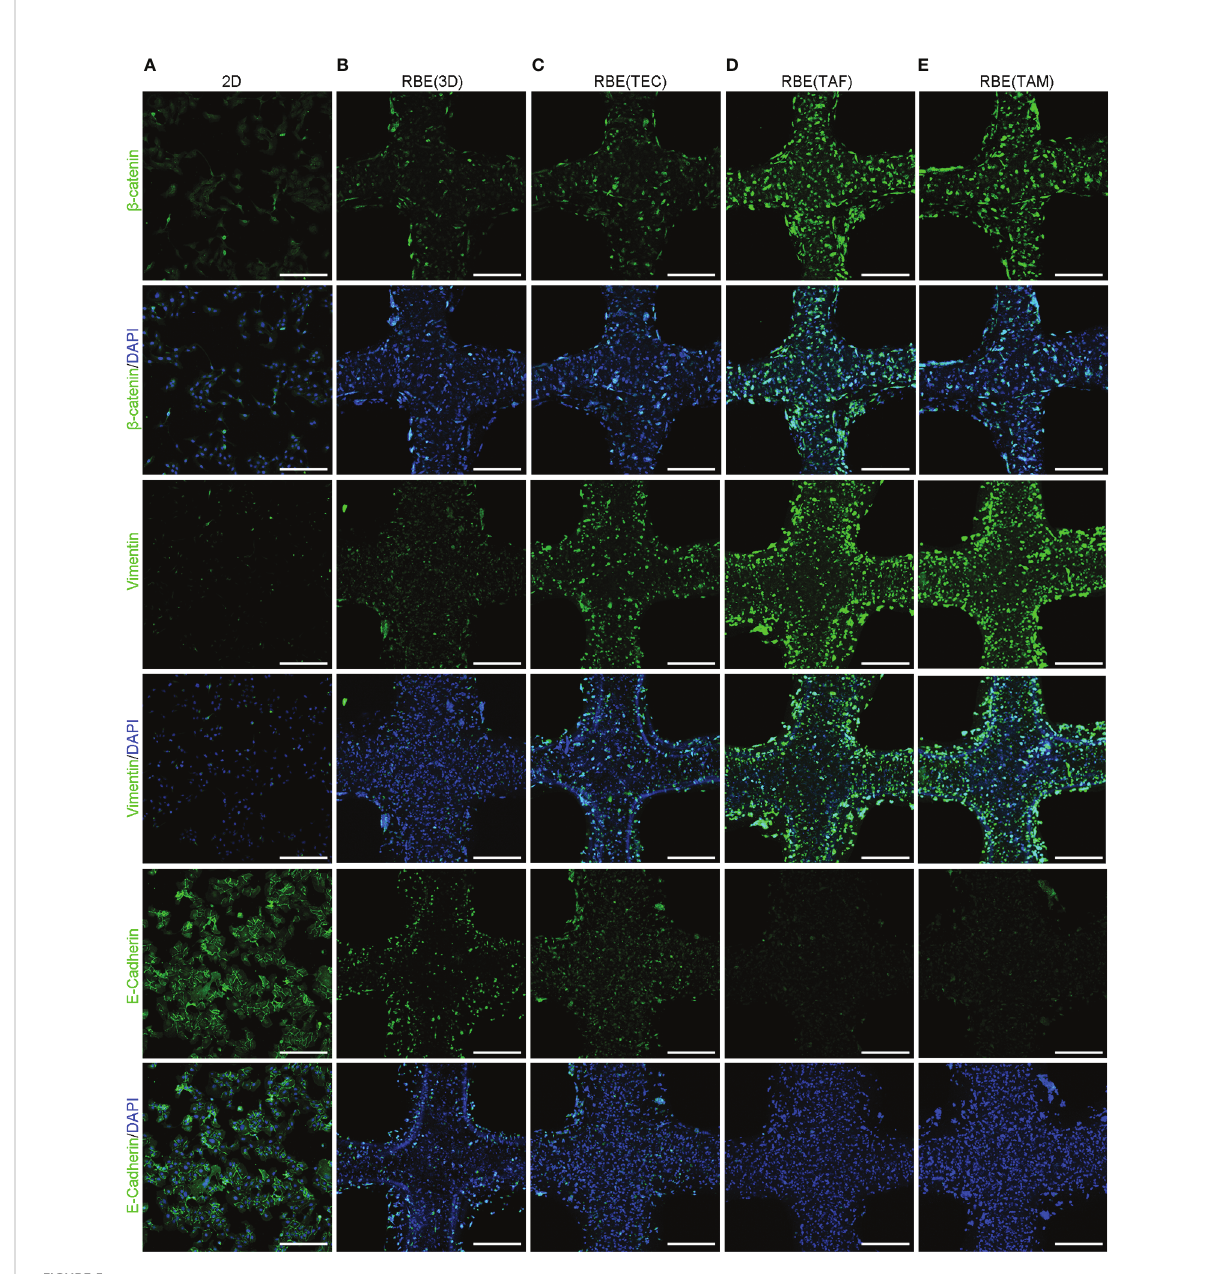
FIGURE 5 3D bioprinting promotes EMT may via the Wnt/ b -catenin pathway in CCA. (A – E) The results of IF staining, including b -Catenin, Vimentin and E- Cadherin in the 2D at appropriate density and 3D bioprinted models at 7 days after 3D bioprinting. Scale bars: 40 m m. The experiments were replicated at least three